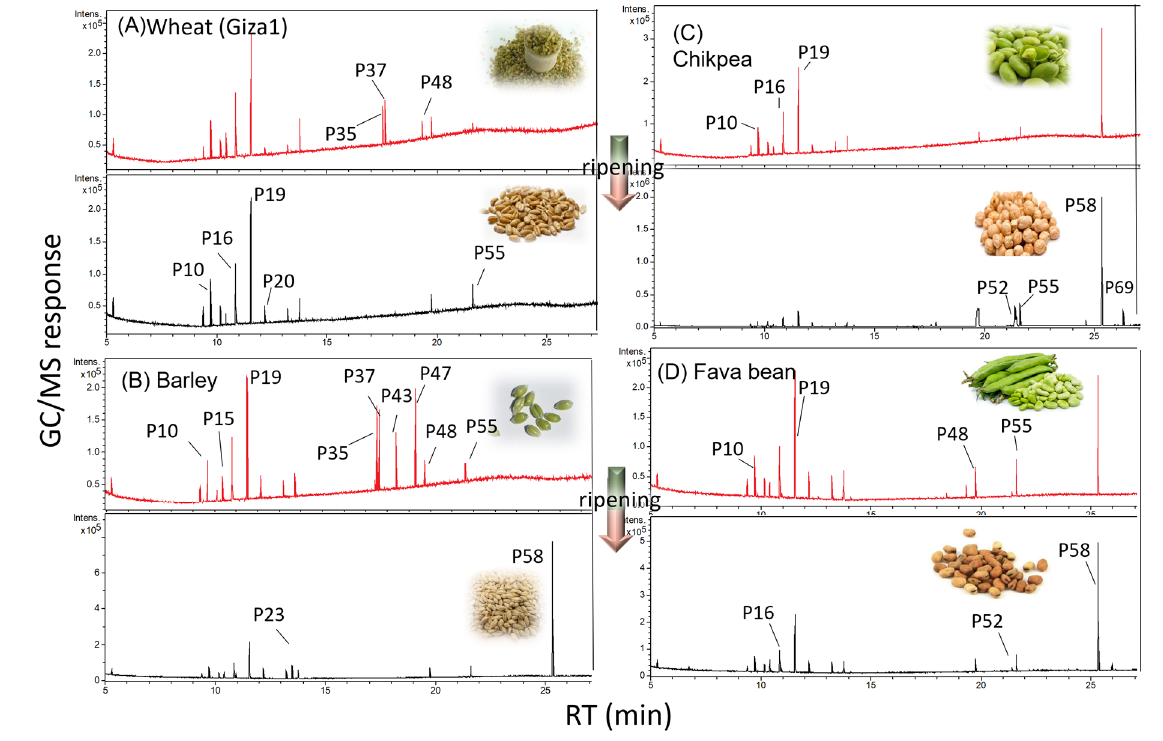
Figure 1. GC/MS chromatogram of silylated metabolites in ( A ) T. aestivum (cv. Giza1); ( B ) H. vulgare (cv. Giza 3); ( C ) C. arietinum (cv. Giza 1); ( D ) V. faba (cv. Sakha 3). Chromatograms are coded, where red is the immature stage, and black is the mature stage. Photos of samples are added in the top-right corner of each chromatogram. The corresponding metabolite number for each peak follows that listed in Table 2.